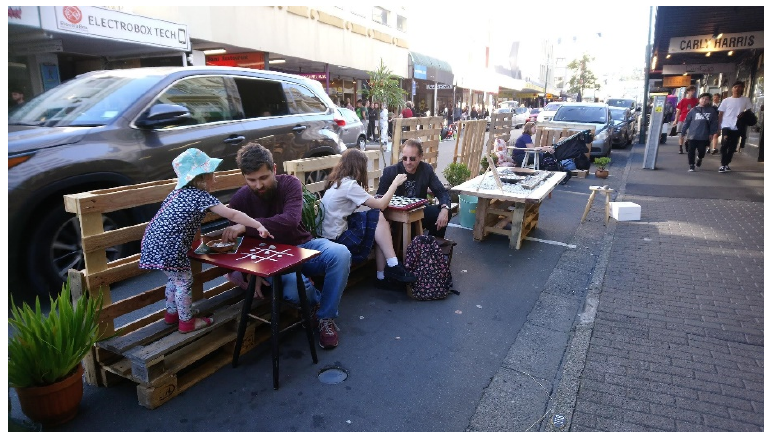
Figure 4. Park(ing) Day in Wellington (2020)—installation designed by K. Herman, M. Rodgers, J. Coppard, A. Meredith-Vaughan. (Photo M. Rodgers).